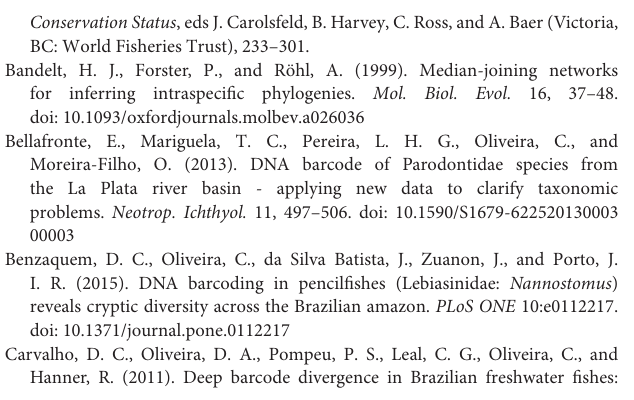
bold indicate sequences generated in the present study and asterisks represent BOLD accession numbers. Supplementary Table S2 | Pairwise F ST values among mitochondrial lineages of Prochilodus . ∗ P < 0.05. Supplementary Table S3 | Analysis of molecular variance (AMOVA) among lineages of Prochilodus . Groups were ordered on the basis of previous ML and Bayesian analyses (see section Material and Methods). Supplementary Figure S1 | Neighbor-joining tree of the species of Prochilodus based on partial sequences of the cytochrome oxidase c subunit I. Numbers near nodes represent bootstrap support. Supplementary Figure S2 | Maximum likelihood tree of the Prochilodus species based on partial sequences of the cytochrome oxidase c subunit I. Numbers near nodes represent bootstrap support. Colors match those in Figure 1 . Supplementary Figure S3 | Haplotype network of the eight mitochondrial lineages of Prochilodus . Each circle represents a unique haplotype and the size proportional to haplotype frequency. Colors match those in Figure 1